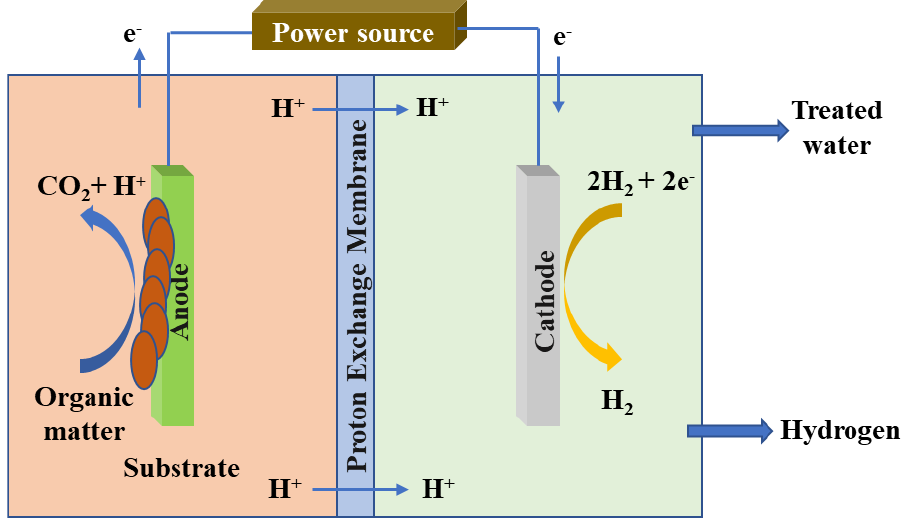
Figure 2. A schematic diagram of a microbial electrolysis cell.